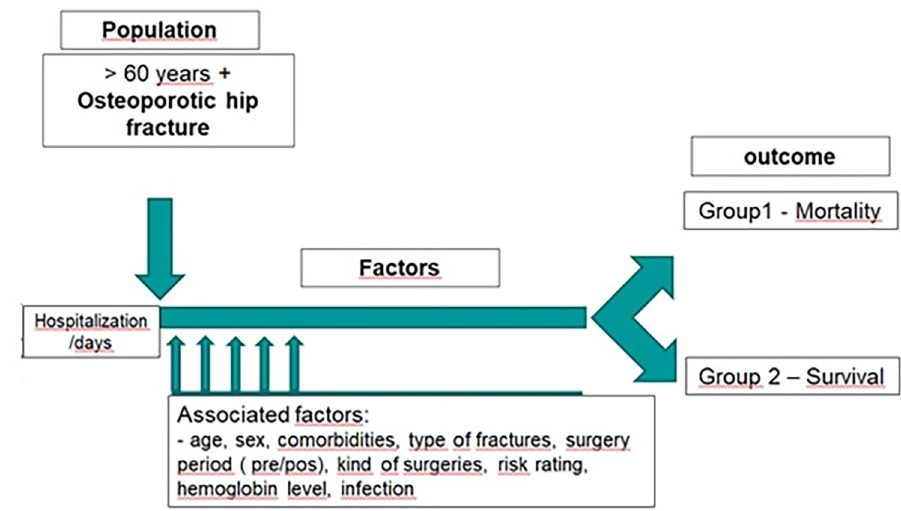
Fig 1. Process model of data extraction and patients’ follow-up during